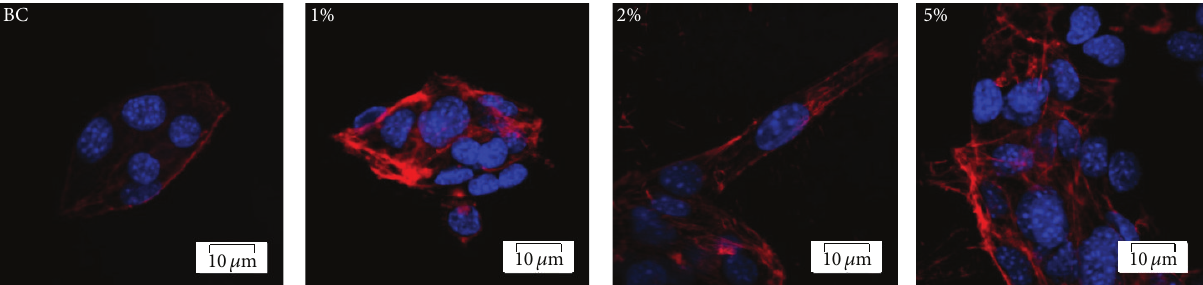
Figure 7: Confocal fluorescence microscopy micrographs of hASCs actin filaments network (red fluorescence) in hASCs/BC, hASCs/BC/ magnetite 1%, hASCs/BC/magnetite 2%, and hASCs/BC/magnetite 5%, DAPI-stained nuclei are blue.